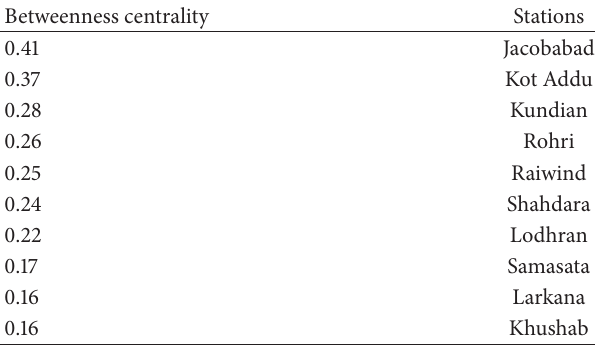
Table 2: Betweenness centrality of top ten stations. Betweenness centrality